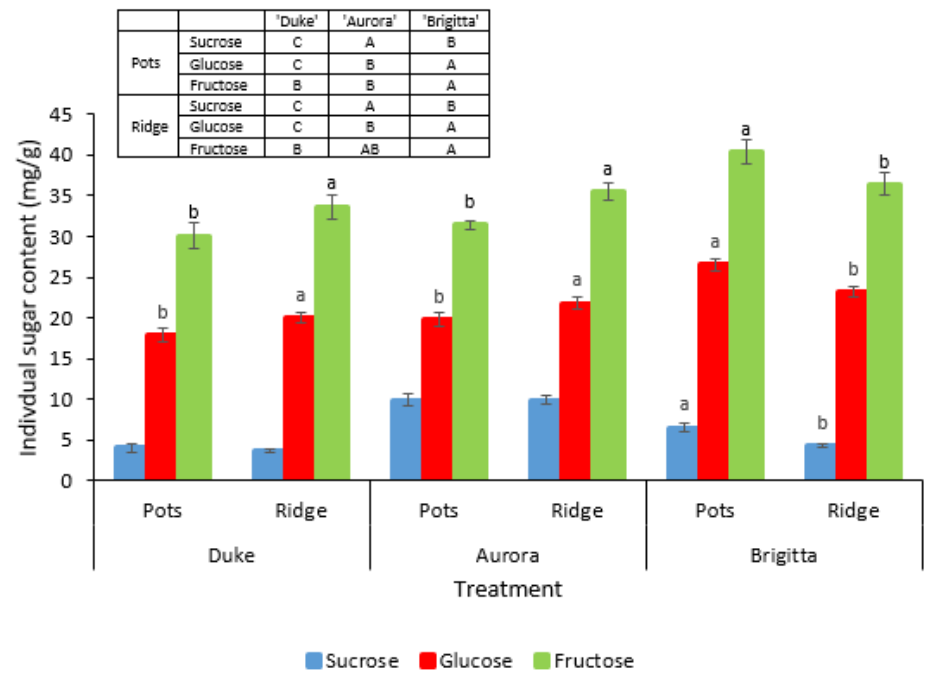
Figure 5. Sucrose, glucose, and fructose contents for the ‘Duke’, ‘Aurora’, and ‘Brigitta’ blueberries harvested from plants grown in pots and along the ridge. Different lowercase letters indicate statis ‐ tically significant differences for each sugar between planting methods within cultivars ( t ‐ tests, α < 0.05), and different uppercase letters (inset) for each sugar between cultivars within planting meth ‐ ods (LSD tests, α < 0.05).